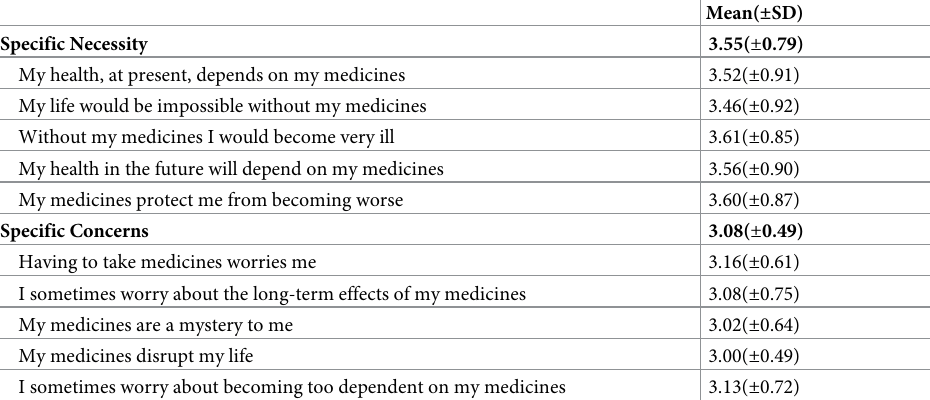
Table 3. Beliefs about medicines